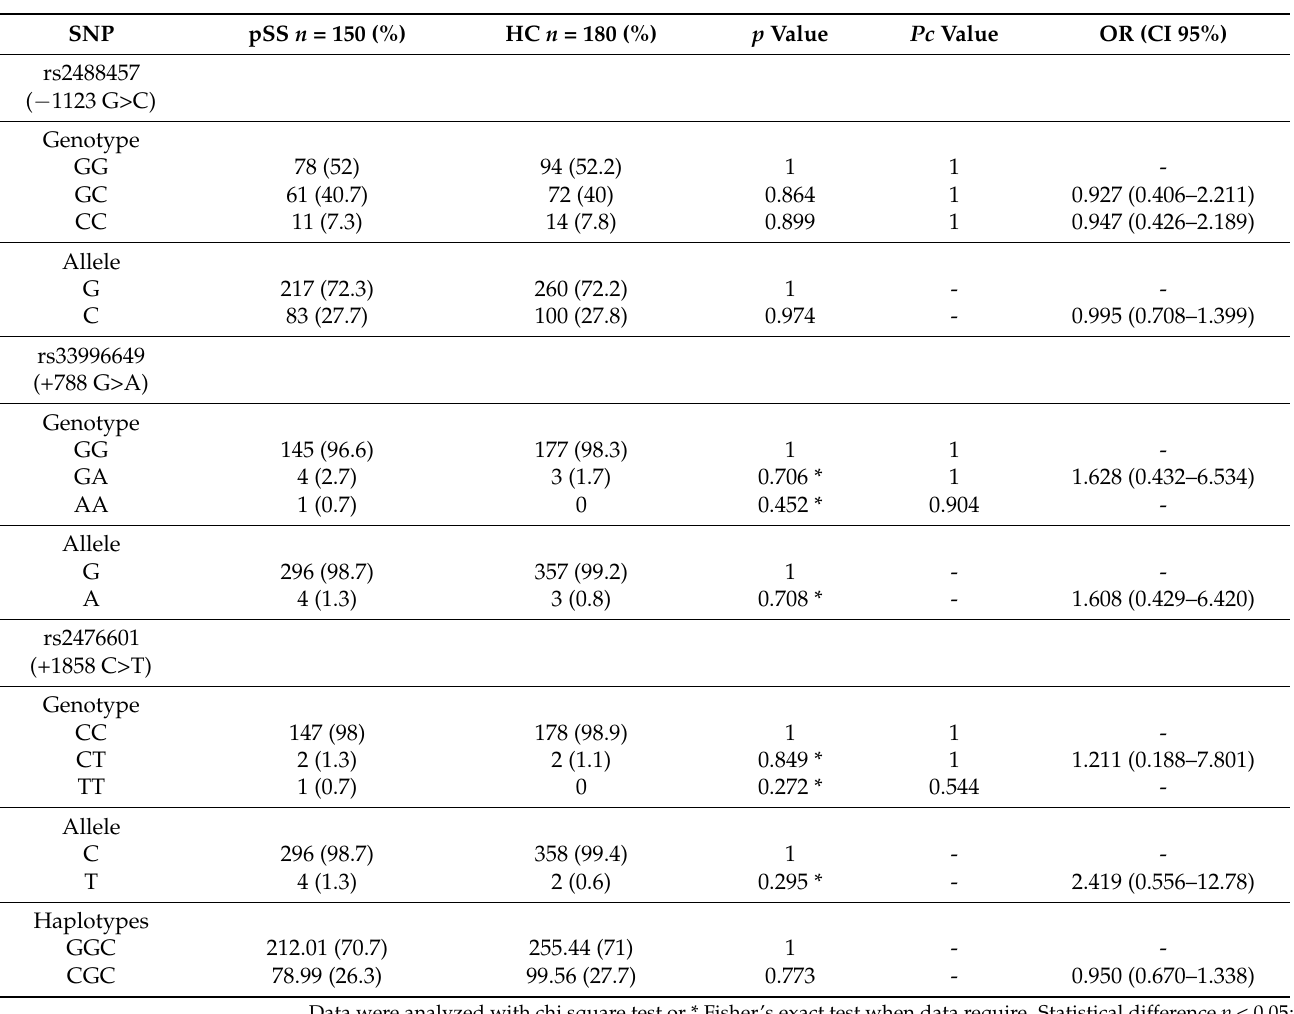
Table 3. Genotype, allele and haplotype frequencies of PTPN22 rs2488457G>C, rs33996649G>A and rs2476601C>T polymorphisms in pSS and HC